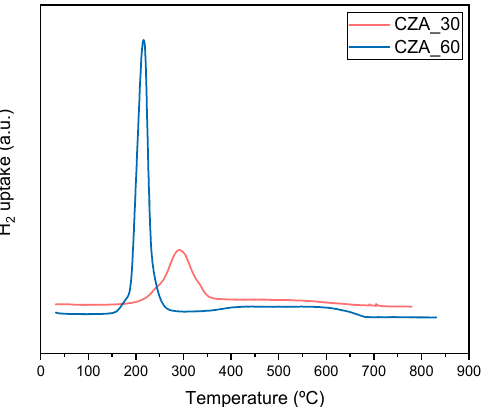
Figure 1. Temperature reduction profiles for CZA_60 (blue line) and CZA_30 (red line). The surface composition of the reduced catalysts (30 min at 250 °C under 20% H 2 in N 2 , ramp 2 °C/min) was analyzed by X-ray photoelectron spectra (XPS). The spectra of